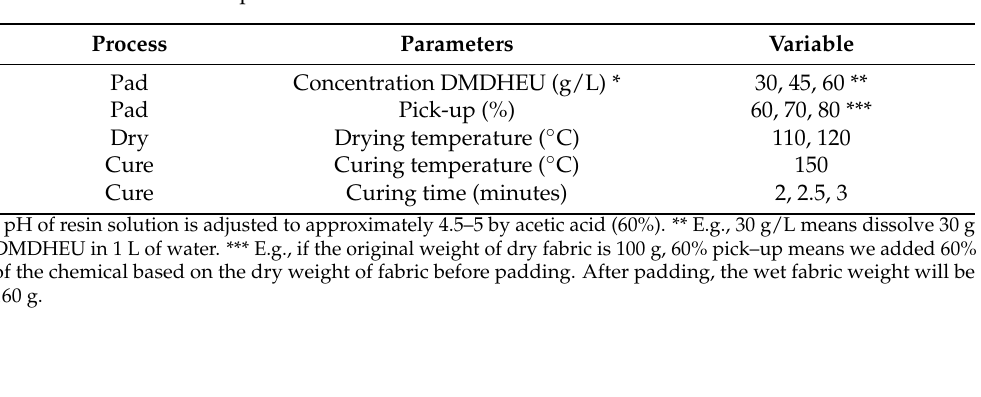
Table 1. Resin treatment